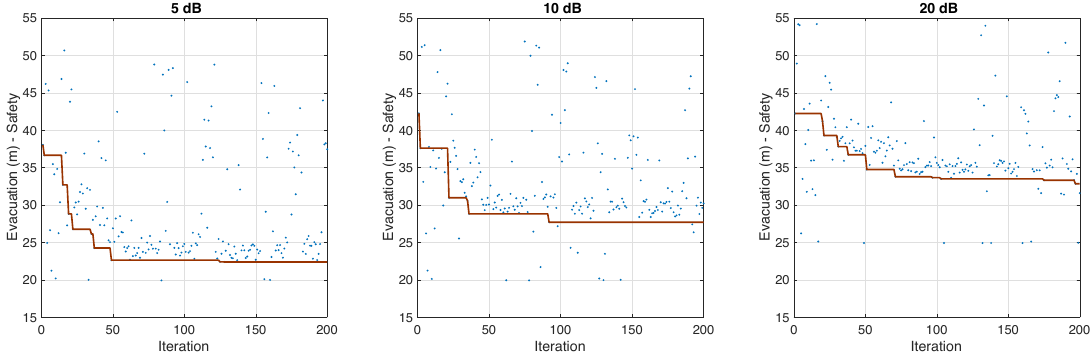
Figure 11. Progress of the Tabu-search simulation optimization of the MLM models that implement the CellEVAC guidance system for σ g equal to 5, 15 and 20 dB. Solutions below the current best solution (red line) correspond to non-viable solutions.